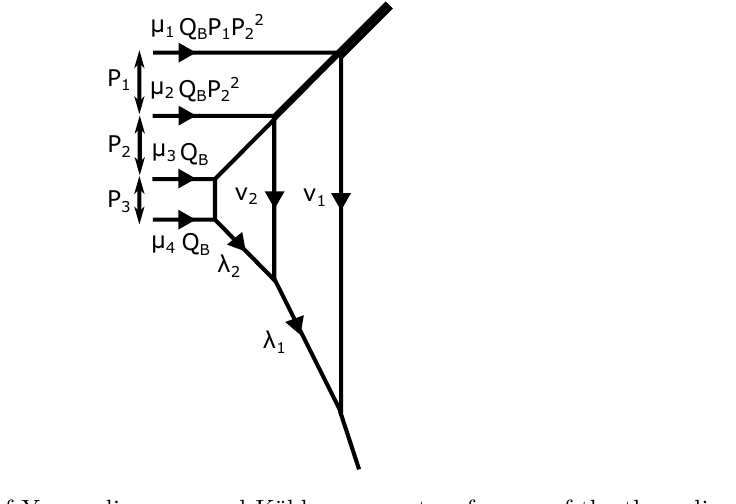
Figure 52. Assignment of Young diagrams and Kähler parameters for one of the three diagrams in figure 49(b). The parametrization of the other diagrams is also the same one as this.